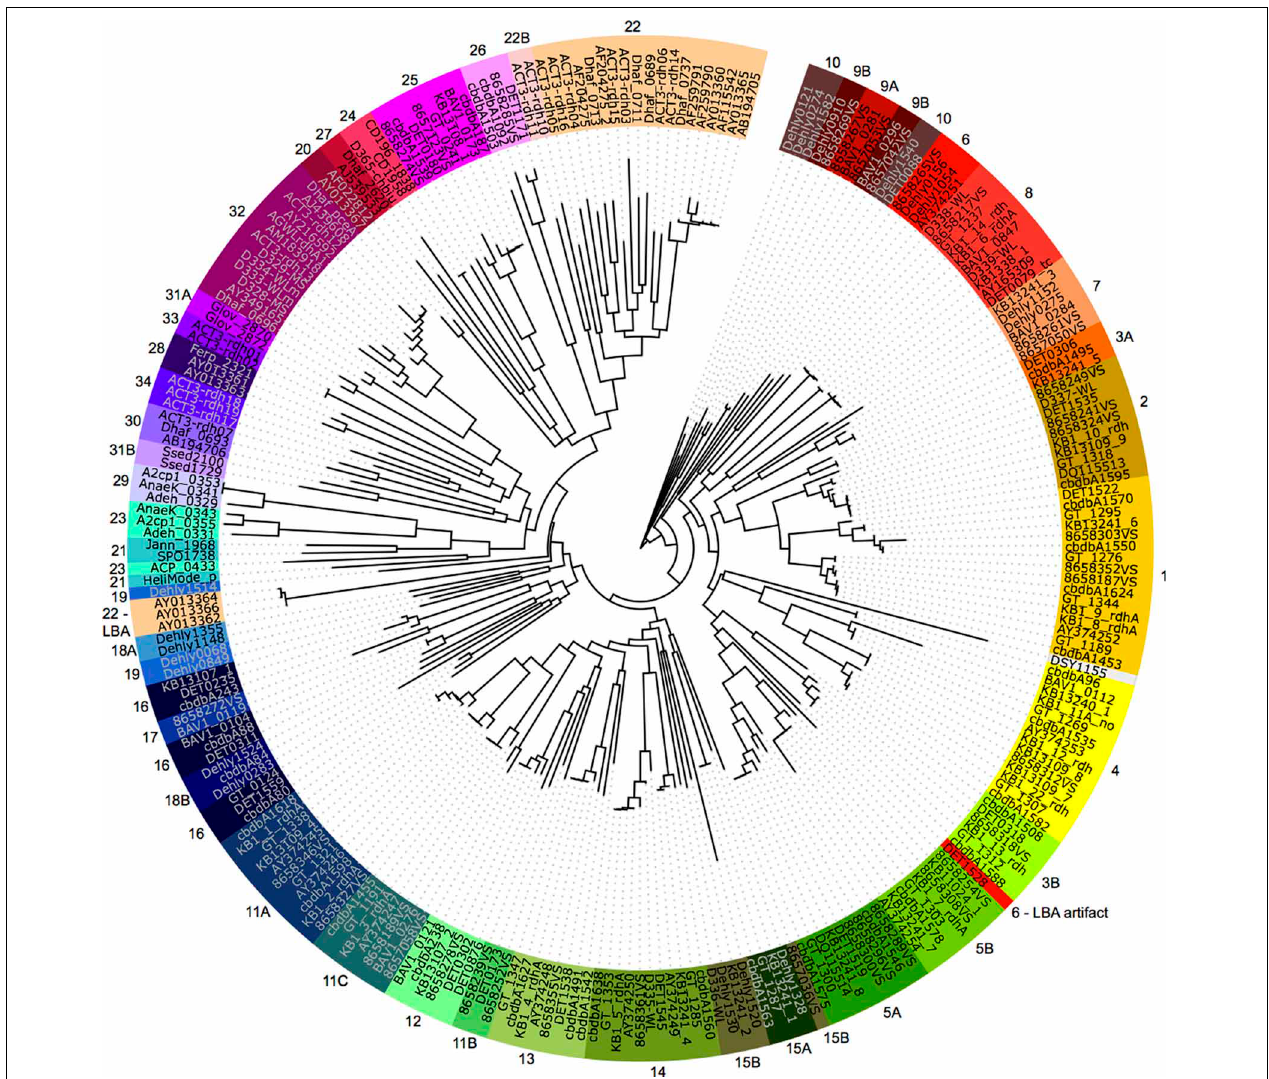
FIGURE 1 | The 44 phylogeny-derived groups for degenerate PCR primer design. Maximum likelihood phylogeny of 255 reductive dehalogenases and reductive dehalogenase homologous genes based on a nucleotide alignment. The genes are colored by group, where each group was separately realigned and primer sets designed. Group numbers were